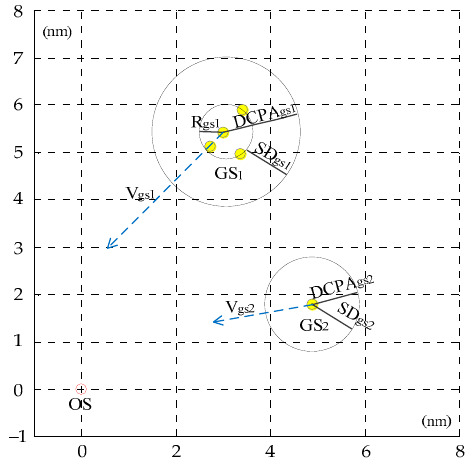
Figure 1. Samples of the group